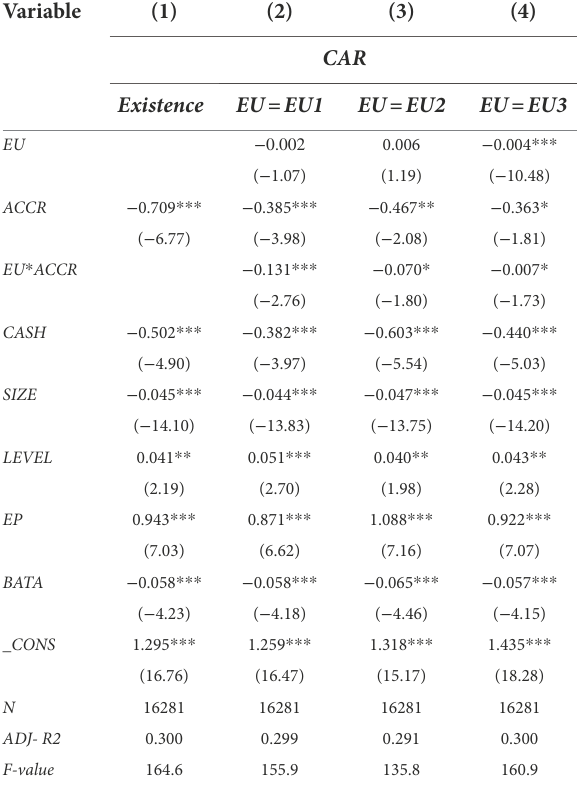
TABLE 4 Accrual anomaly test and the influence of environmental uncertainty on it.